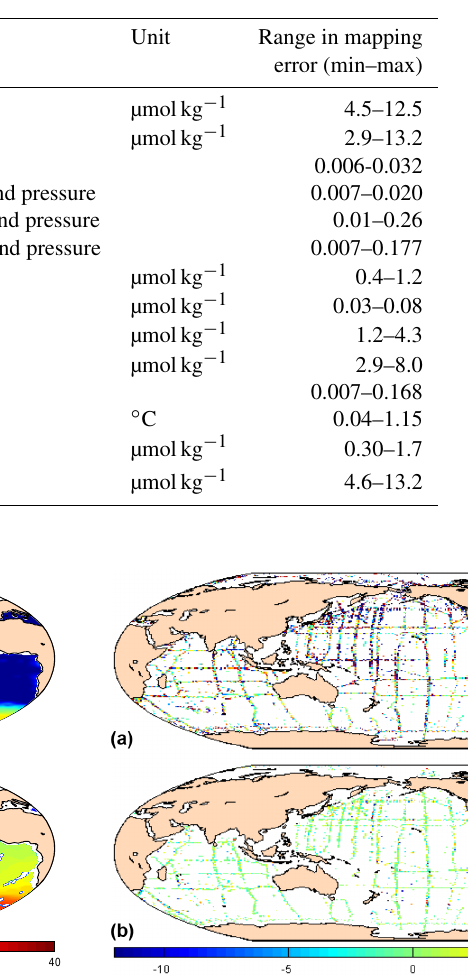
Table 3. Table of the range in mapping error averaged spatially over all depth surfaces for the individual parameters.